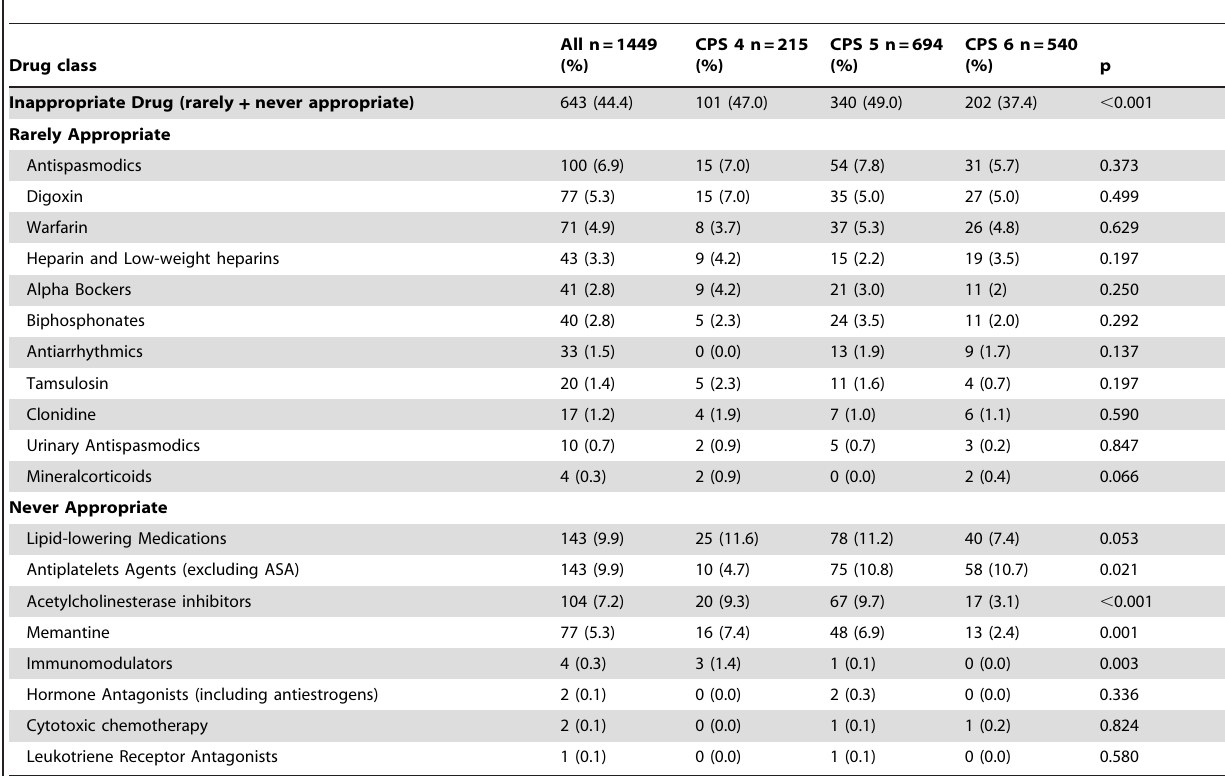
Table 2. Inappropriate drug use according to the Cognitive Performance Scale (CPS)